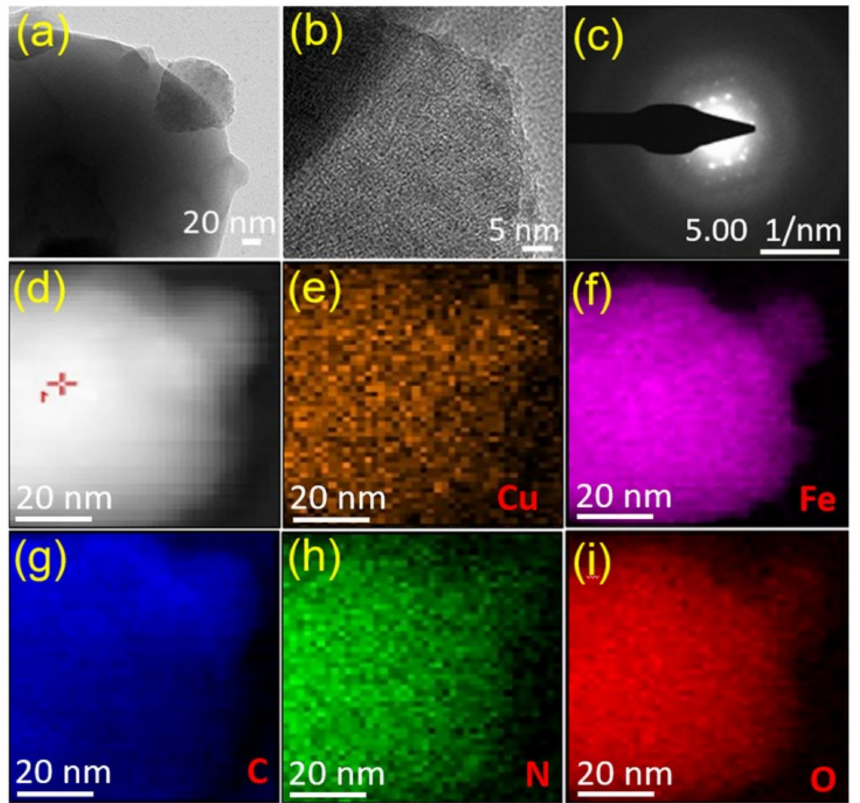
Figure 3. ( a ) TEM image, ( b ) HR-TEM image, ( c ) SAED pattern, ( d ) HAADF STEM image, and ( e – i ) element distribution mapping on a Cu/Fe-MOF nanosheet. Individual elements: Cu (orange), Fe (pink), C (blue), N (green), and O